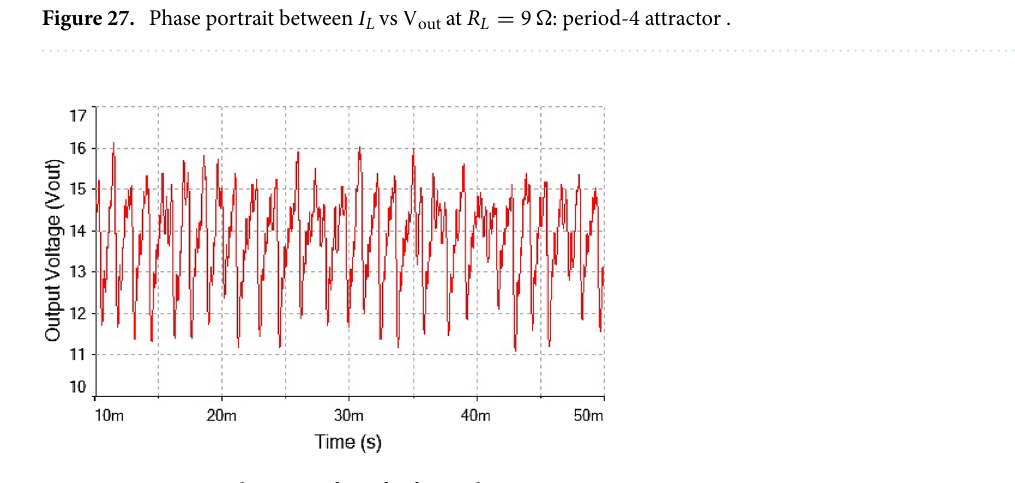
Figure 28. Output voltage waveform for forward converter at at R L = 11 (cid:31)